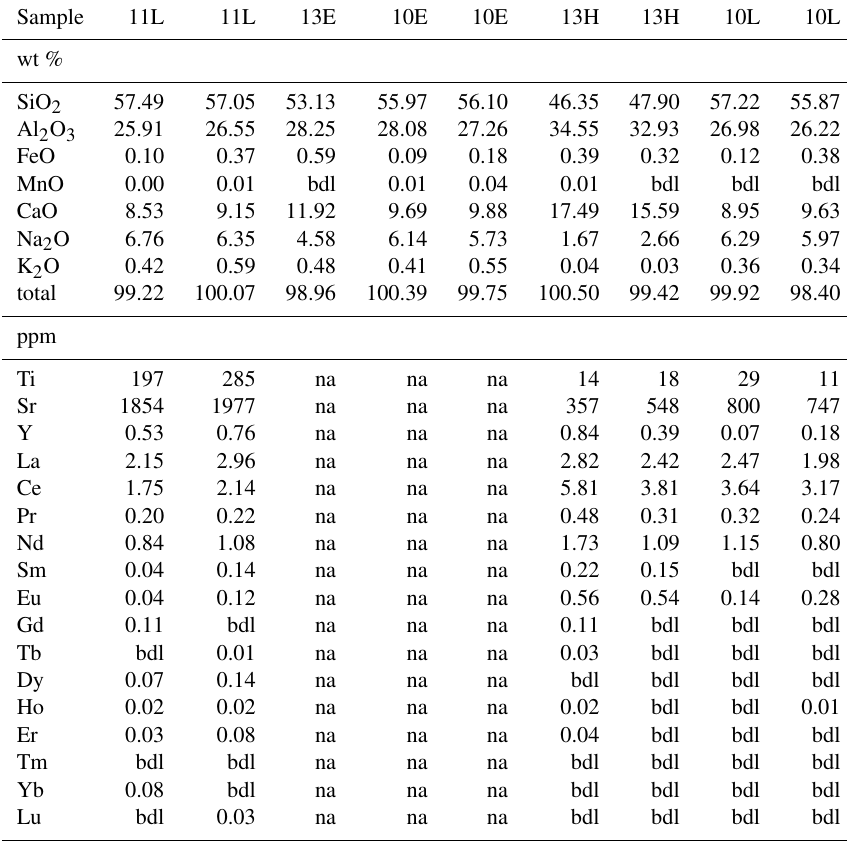
Table 4. Major and trace element composition of plagioclase. Sample